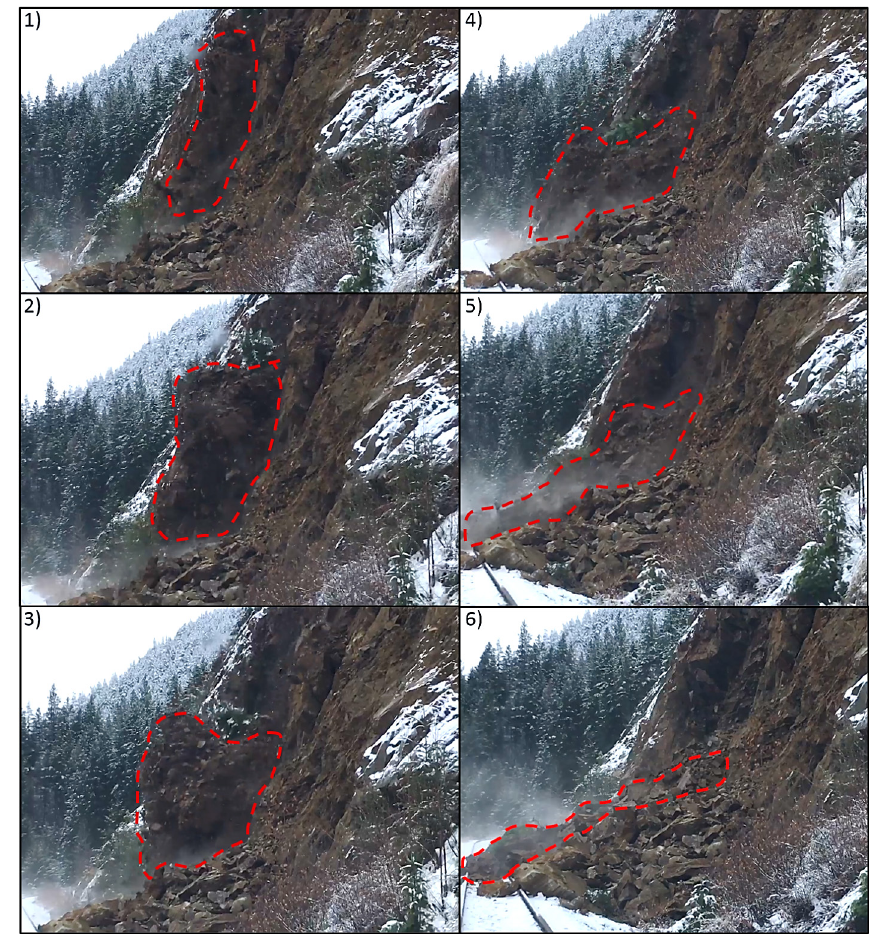
Figure 10. Snapshots from a video of a fragmental rockfall event occurring above a section of railway in western Canada. Elapsed time between frame (1) and frame (6) is approximately